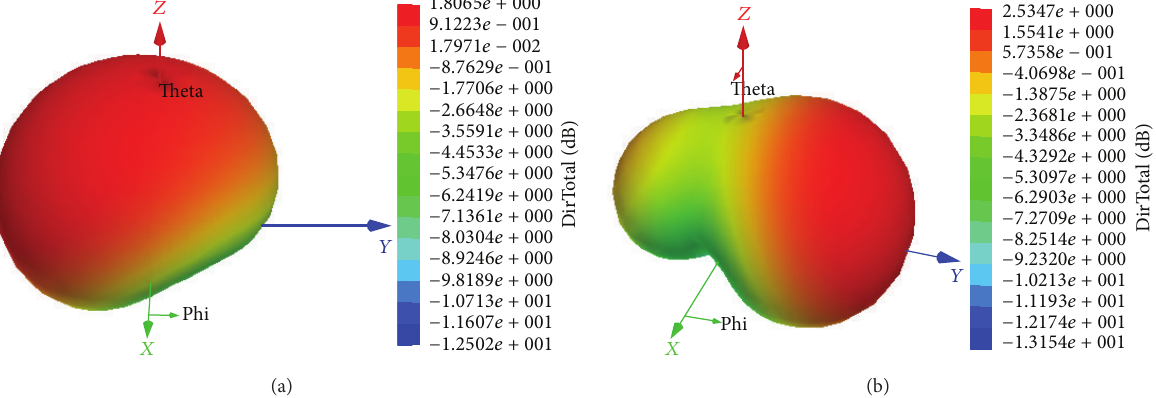
Figure 9: Simulated 3D-radiation patterns for the structure: (a) configuration A1 ( 𝐹 𝑅 = 1.55 GHz), (b) configuration A2 ( 𝐹 𝑅 = 1.75 GHz).